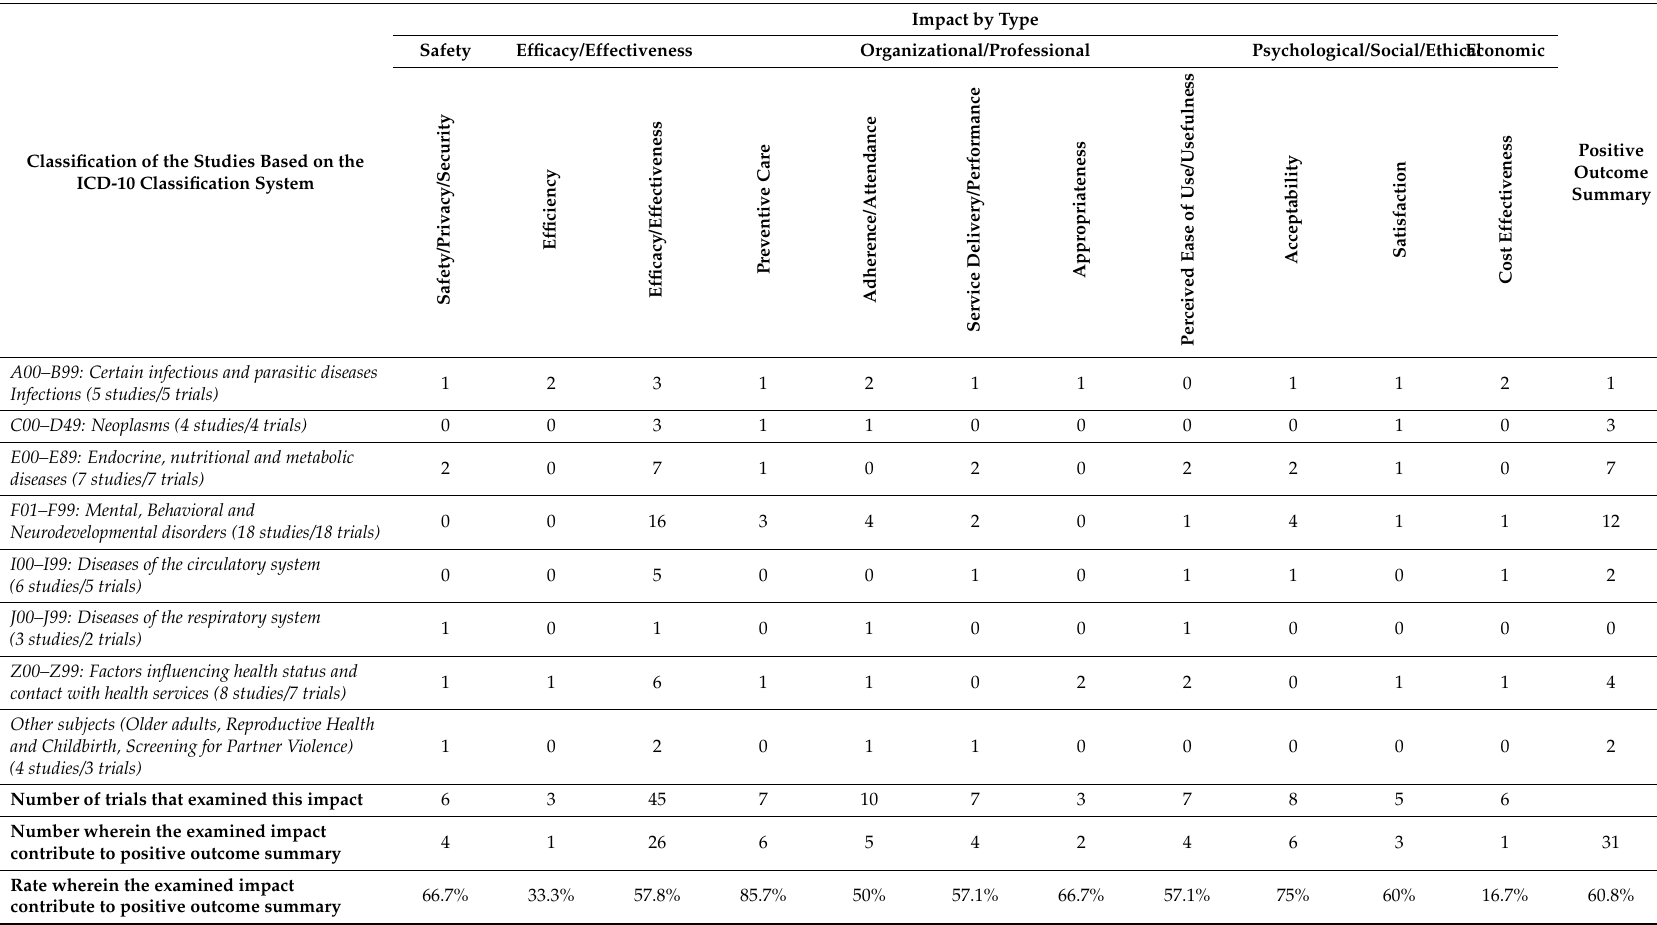
Table 3. Impacts and outcomes of the trials (number and rates) according to1CD-10